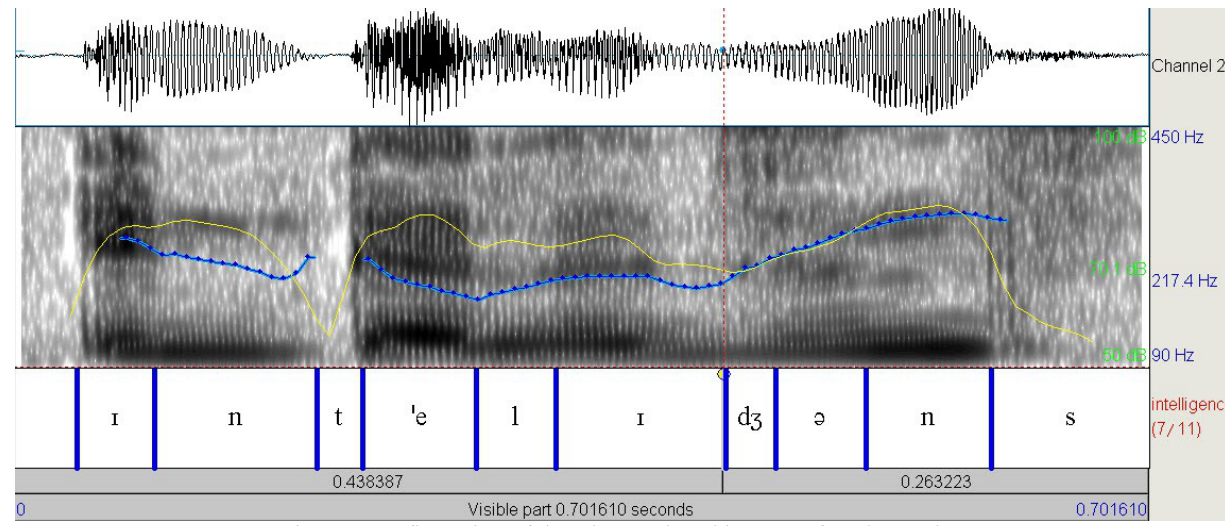
Fig. 4 – Configuration of the Rise produced by an IE female speaker Notes: blue curve signifies F0; yellow curve signifies